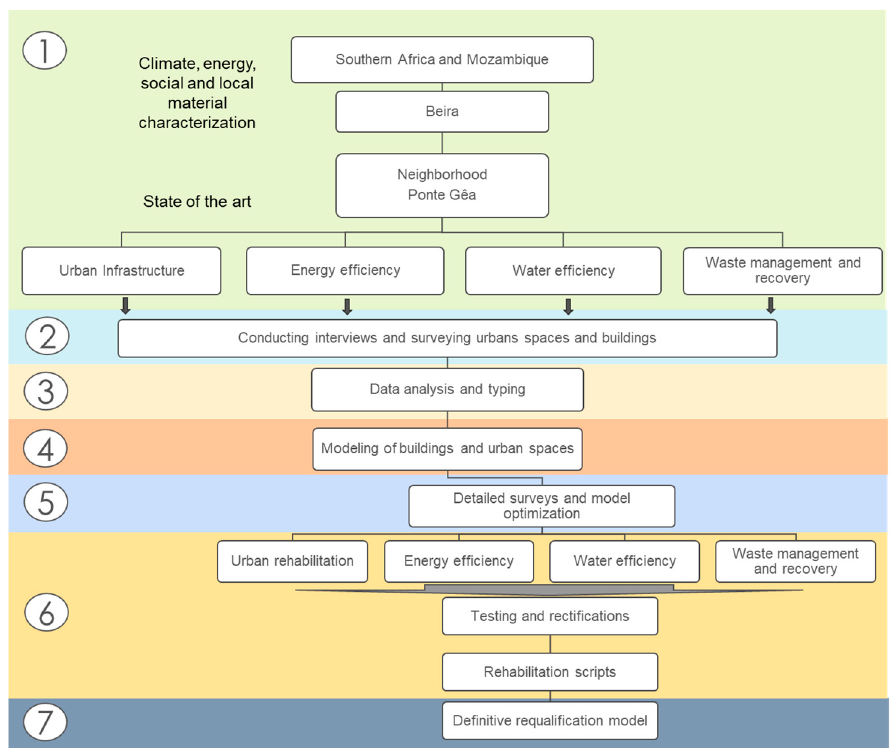
Figure 4. Proposal of different levels for defining a model for rehabilitation for the neighborhood of Ponte Gêa.